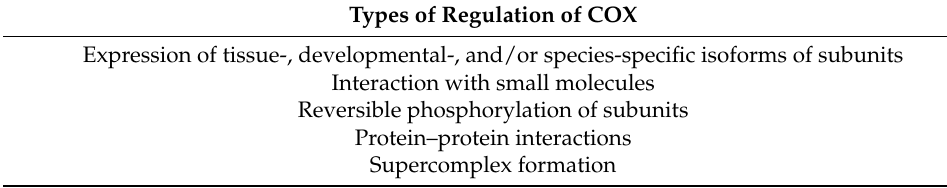
Types of Regulation of